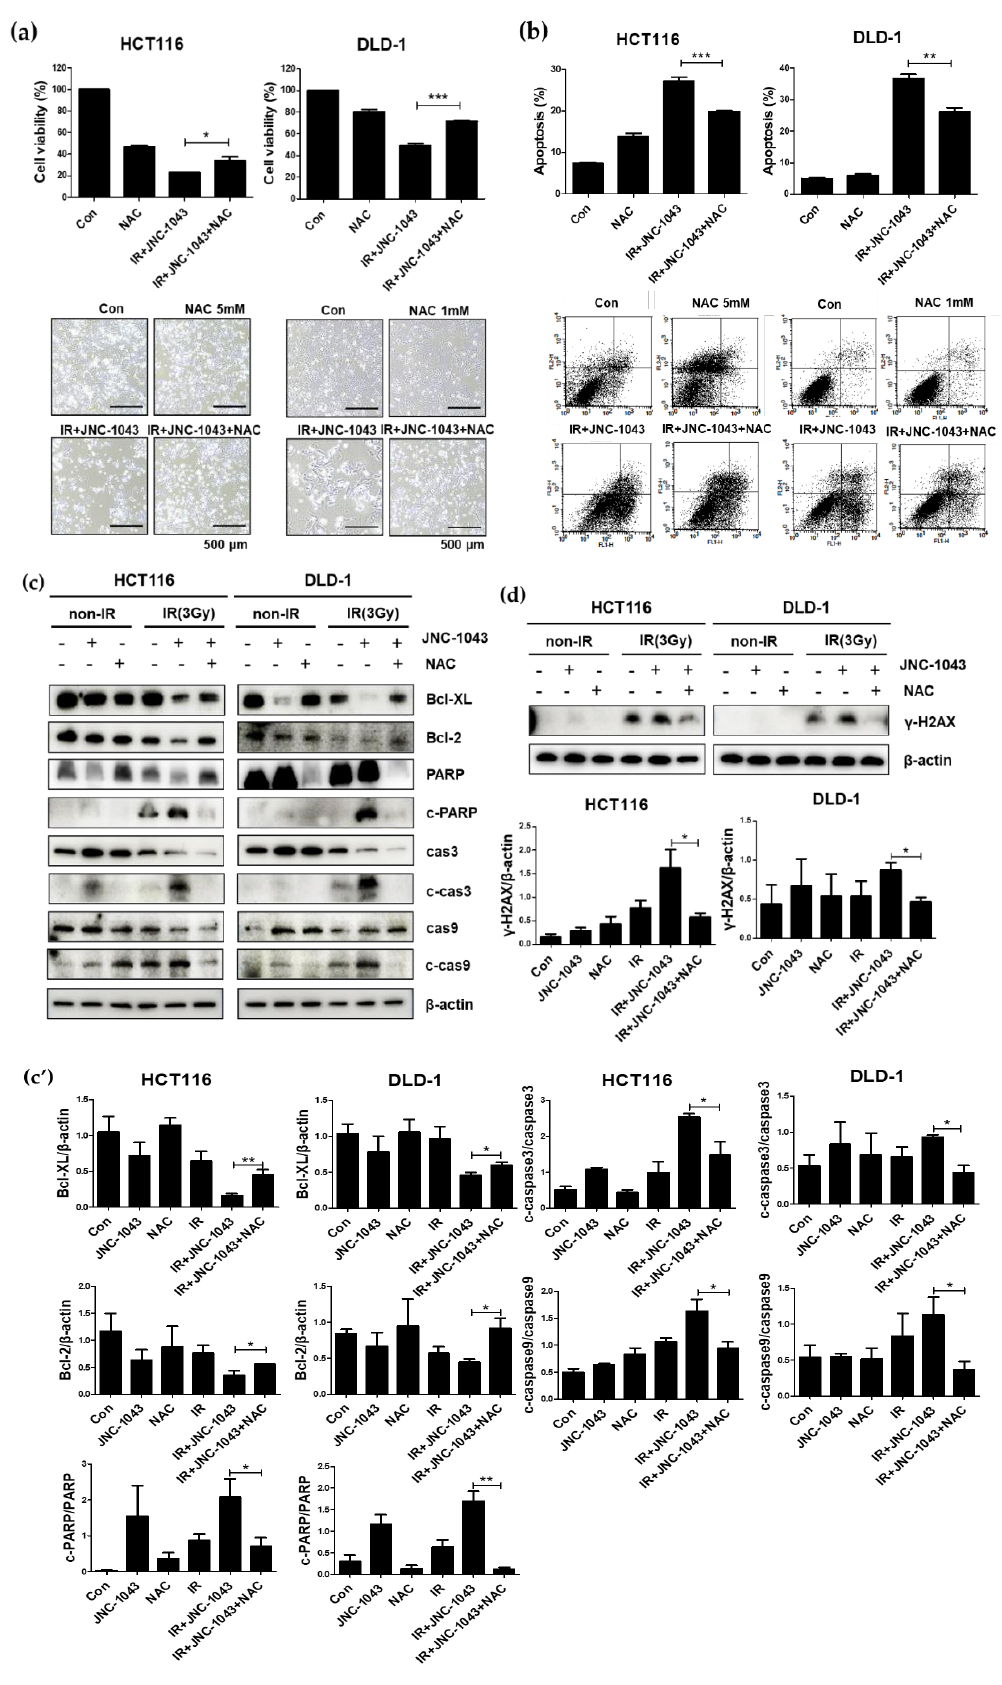
Figure 8. Blockage of ROS decreases the radiosensitizing ability of JNC-1043. ( a ) Cell viability in JNC-1043 and IR co-treated CRC cells with or without NAC pre-treatment for 2 or 1 h, respective- ly. HCT116 and DLD-1 cells (1 × 10 5 ) were incubated with or without 110 or 150 nM JNC-1043, re- spectively, exposed to 3 Gy IR and incubated for 72 h prior to harvest. ‘Con’ DMSO -treated mock control; ‘NAC’, HCT116 or DL D-1 cells pre-treated with 5 or 1 mM NAC, respectively; ‘IR+JNC -104 3′ , combination of 110 or 150 nM JNC- 1043 with 3 Gy IR; ‘IR+JNC - 1043+NAC’, com- bination of 3 Gy IR with 110 or 150 nM JNC-1043 in cells pre-treated with 5 or 1 mM NAC, respec- tively. The lower panel shows microscopic images obtained prior to cell detachment. Each bar in the pictures indicates 500 μ m. ( b ) Annexin V-PI uptake assay for detection of apoptosis in CRC cells co-treated with JNC-1043 and IR for 72 h with or without NAC pretreatment for 2 or 1 h, re- spectively, as detected using a FACSort flow cytometer. The lower panel shows representative FACSort flow cytometry images obtained prior to quantitative analyses. Experiments were re- peated in triplicate, and the results indicate the mean of triplicate assay. ( c , d ) Immunoblot assay for detection of apoptosis-related proteins ( c ) and its relative band densities ( c ’ ), and γ H2AX acti-